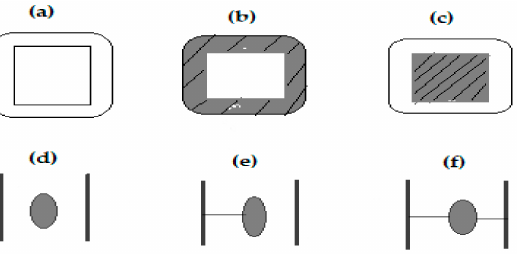
Figure 1. Different types wood modification at the cellular level [30]. Table 1. Different types of wood modification [5].